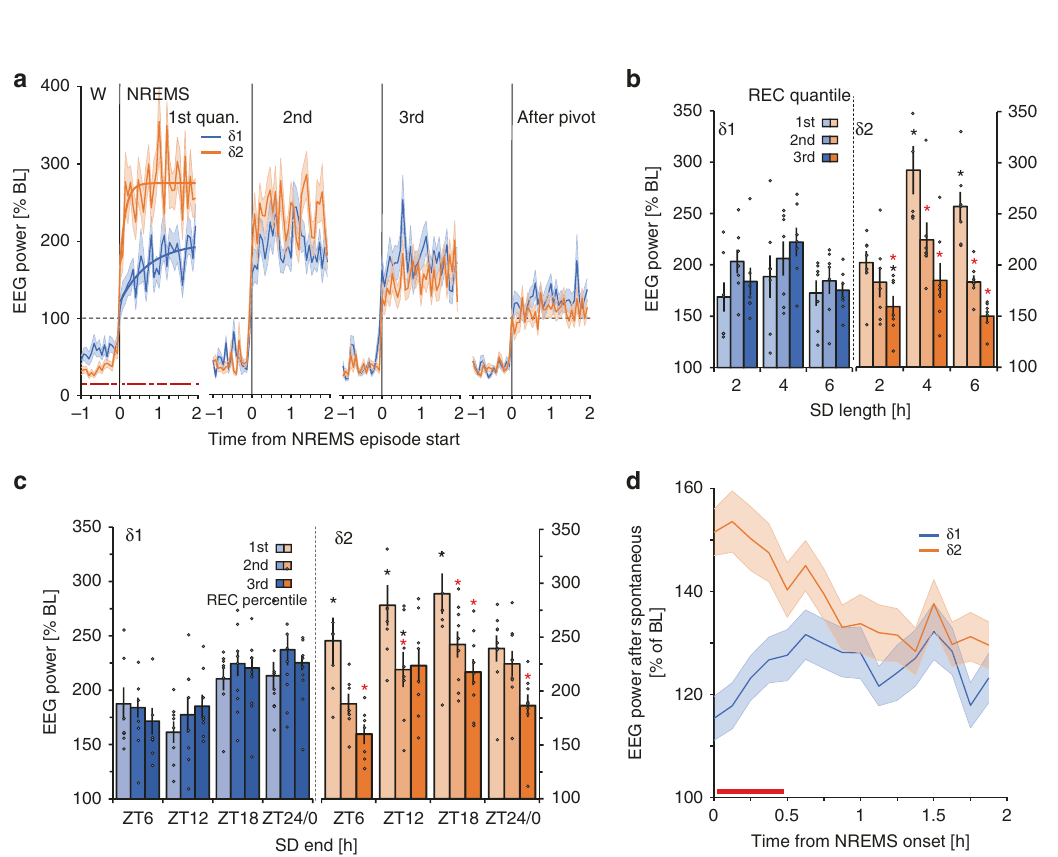
Fig. 3 δ 1- and δ 2-dyamics following enforced and spontaneous extended waking. a δ 1- and δ 2-dynamics across wake (W) to NREMS transitions during recovery from 6 h SD differed (red squares represent signi fi cant differences; paired t -tests, p < 0.05, n = 38). Lines represent regressions to saturating exponential functions fi tted to 4 s values starting at NREMS-episode onset (time constants: δ 1 = 44.8s, δ 2 = 8.1 s). b SDs starting at light onset (ZT0) of different lengths (2-, 4-, and 6 h; n = 7/group). δ 1 showed an effect only across subsequent quantiles (one-way rANOVA factor time: F 2,36 = 9.2, p = 0.0006), whereas δ 2 was sensitive to the length of SD (two-way rANOVA factors time × SD length: F 4,36 = 5.0, p = 0.003), and different from δ 1 (three- way rANOVA factors time × SD length × sub-band: F 4,72 = 3.2, p = 0.02). Asterisks represent post-hoc signi fi cance ( p < 0.05) for differences from fi rst quantile (red), or for δ 1 vs. δ 2 (black). c Effect of time-of-day at which SD ends on δ 1 and δ 2. Asterisks same as in b (one-way rANOVA factor SD-end; δ 1: F = 3.86, p = 0.02; δ 2: F = 3.92, p = 0.02; n = 8/group). Black circles represent individual datapoints ( d ) NREMS following prolonged spontaneous 3,30 3,30 waking (1.6 ± 0.1 h) during the baseline dark period showed initial increases for δ 2-power which then decreased across subsequent NREMS episodes, whereas δ 1 did not (two-way rANOVA factors sub-band × time: F 15,1110 = 4.9, p = 2.2E-09). Red lines in d (post-hoc tests, p < 0.05, n = 38). Data is presented as mean values ±s.e.m. indicated as either error bars or shaded compared to δ 1 with differences between the bands dissipating of 2-, 4-, or 6 h. We found that δ 1-power immediately after SD afterwards (Fig. 3a). was unaffected by differences in preceding SD duration, whereas δ 2 showed high values that increased further for the longest two Next, we quanti fi ed δ 1- and δ 2-power dynamics in the fi rst three recovery quantiles (24.8 ± 0.9 min NREMS) following SDs SDs (Fig. 3b). Independent of SD duration, δ 2 rapidly declined